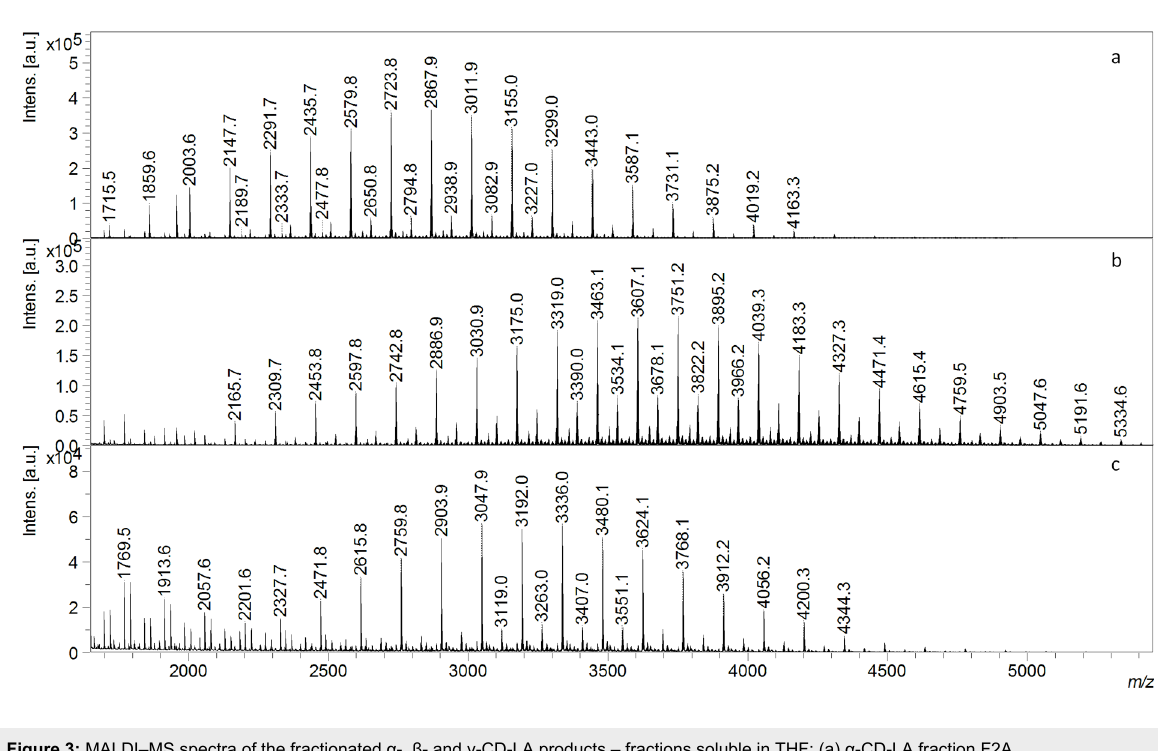
β -CD-LA fraction F2B (Figure 3b) had a number of monomer units ranging from 6 to 28 dilactate units. The M n inferred from the MS spectrum had a value of 3800 g/mol corresponding to approximately 18 dilactate monomer units. The peaks from the species with an odd number of lactate monomer units formed by transesterification reactions ( Δ m / z = 72 Da from the main series) were also present in the spectra. In addition, in the lower region of the MALDI spectrum some peaks corresponding to PLA homopolymers in the lower mass region of the spectrum could also be observed.